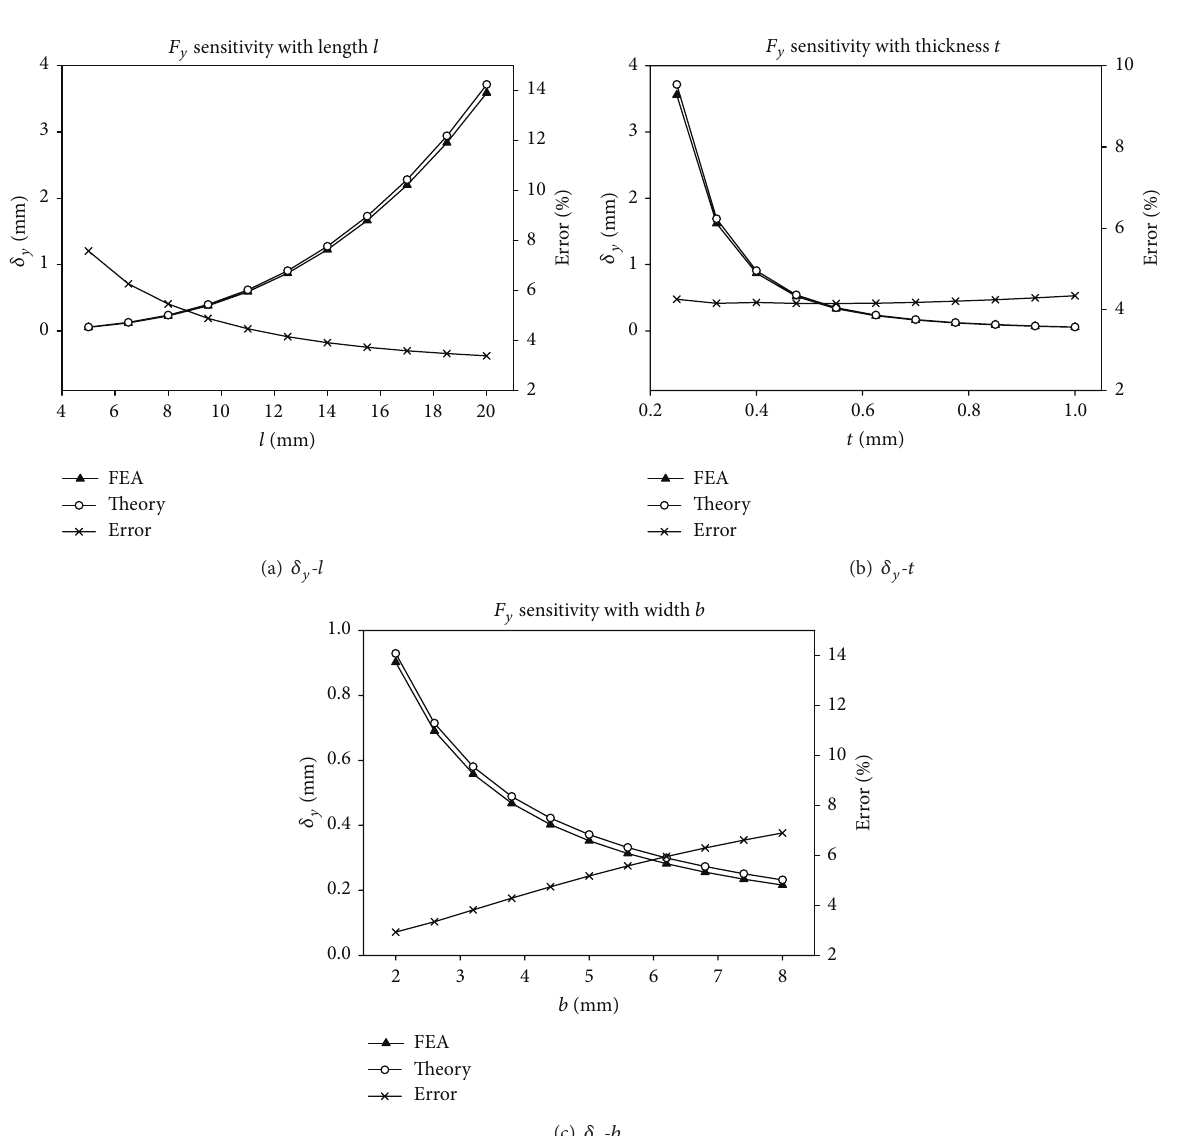
Figure 2: Variation of deflection 𝛿 𝑦 according to (a) length 𝑙 , (b) thickness 𝑡 , and (c) width 𝑏 under 𝐹 𝑦